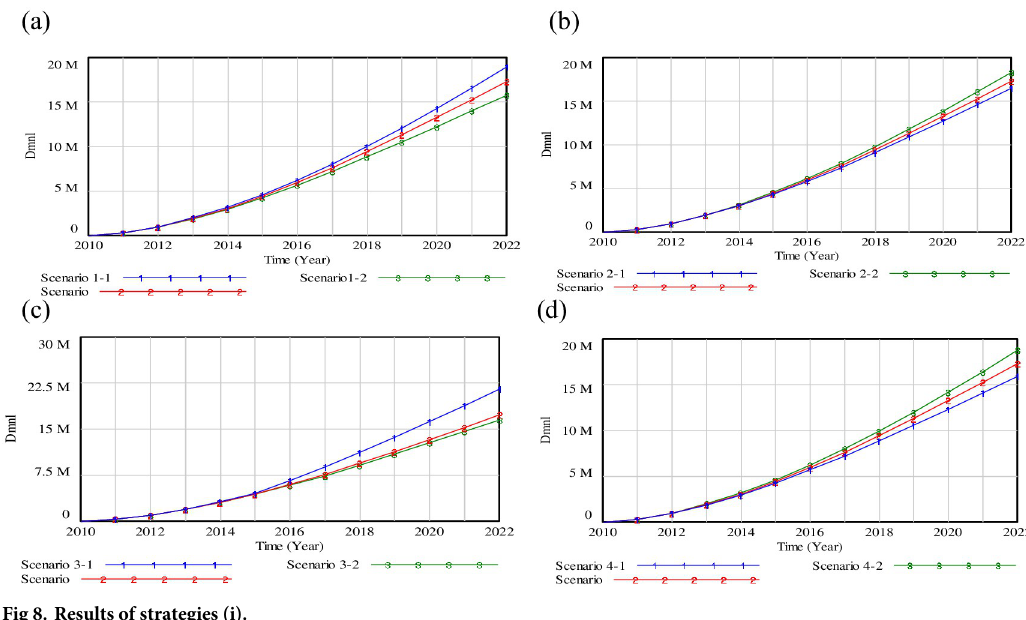
Fig 8. Results of strategies